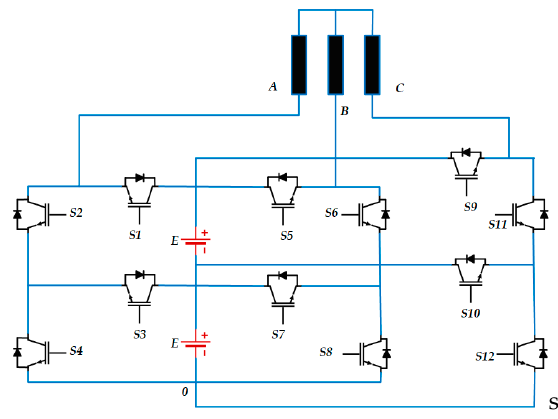
Figure 13. 5 − Level MLI.